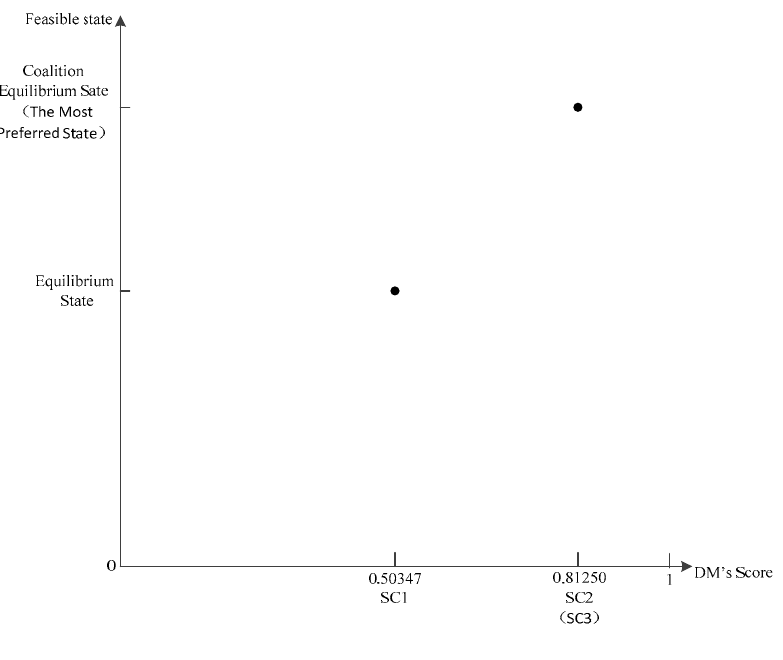
Figure 7. Score coordinate system of EPA (DM1).